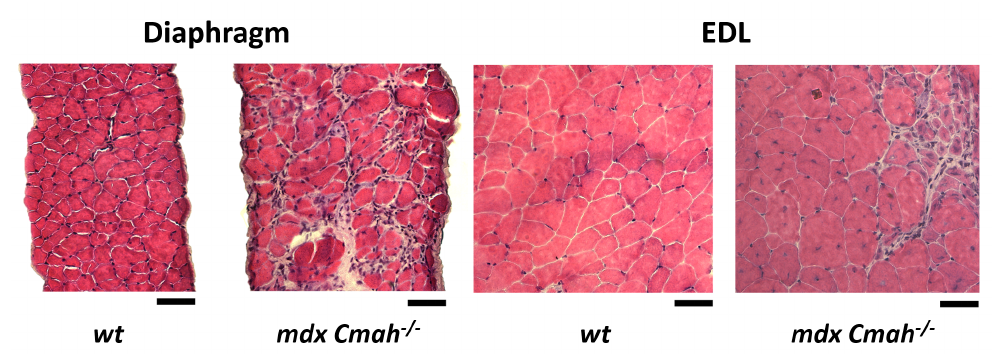
Figure 1. Extensive fibrosis in H&E muscle cross-sections of EDL and diaphragm muscle from mdx Cmah − / − mice. Increased fibrosis and scar tissue is observed in mdx Cmah − / − diaphragm, compared to mdx Cmah − / − EDL muscle (Scale bar 50 µ